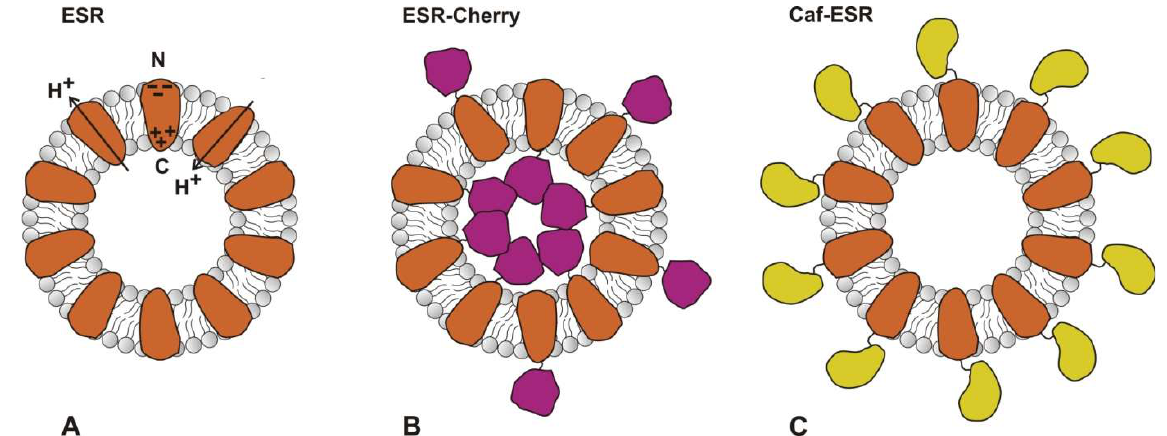
Figure 6. Schematic drawings of proteoliposomes containing ESR and hybrid proteins. ( A ) The wild type ESR is mainly oriented in the N out -C in direction. Only a small portion of molecules (about 5%) possesses an opposite orientation. ( B ) C-terminal soluble domain of ESR-Cherry points to the lumen; however, due to its limited volume, some fraction of molecules inserts in the N in -C out direction. ESR-Trx presumably inserts by the same mechanism. ( C ) N-terminal position of the soluble domain in Caf-ESR promotes unidirectional N out -C in orientation.